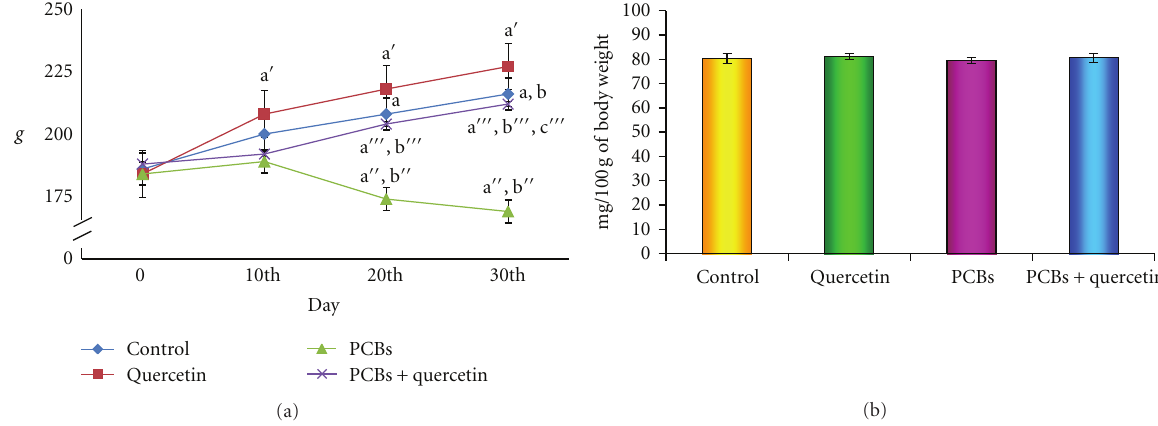
Figure 1: (a), (b): E ff ect of quercetin on body weight and relative hippocampal weight of PCBs-exposed adult rats. Each bar represents mean ± SEM of 6 animals. Statistical significance is at P < 0 . 05 (a: Control versus others; b: Quercetin versus PCB, PCB + Quer; c: PCB versus PCB + Quer). a: Control 0 Day versus 10th day, 20th day, and 30th day; b: Control 10th day versus 20th day and 30th day; a’: Quercetin 0 day versus 10th day, 20th day, and 30th day; b’:Quercetin10th day versus 20th day and 30th day; a”: PCB 0 day versus 10th day, 20th day,